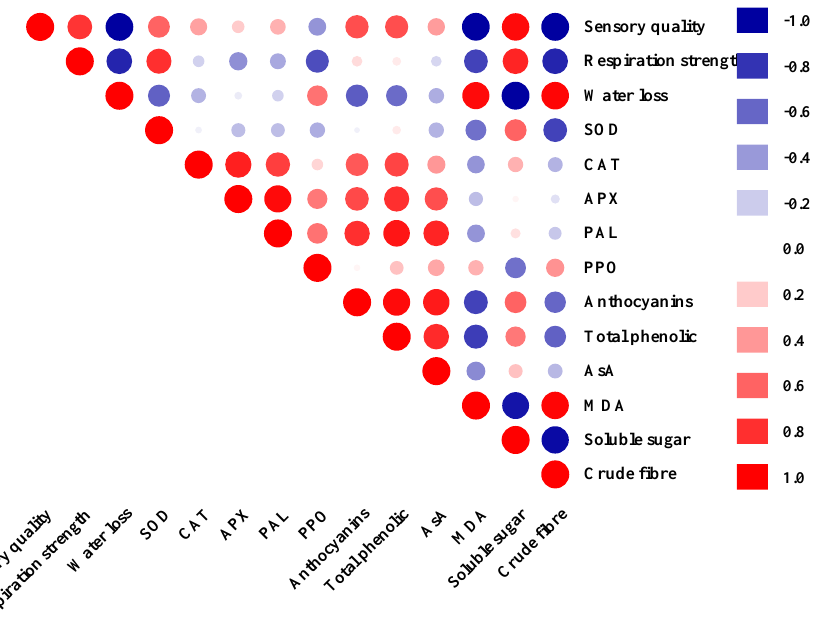
Figure 9. Heatmap of the correlation between sensory quality and physiological metabolic factors of roses treated with 1 − MCP.